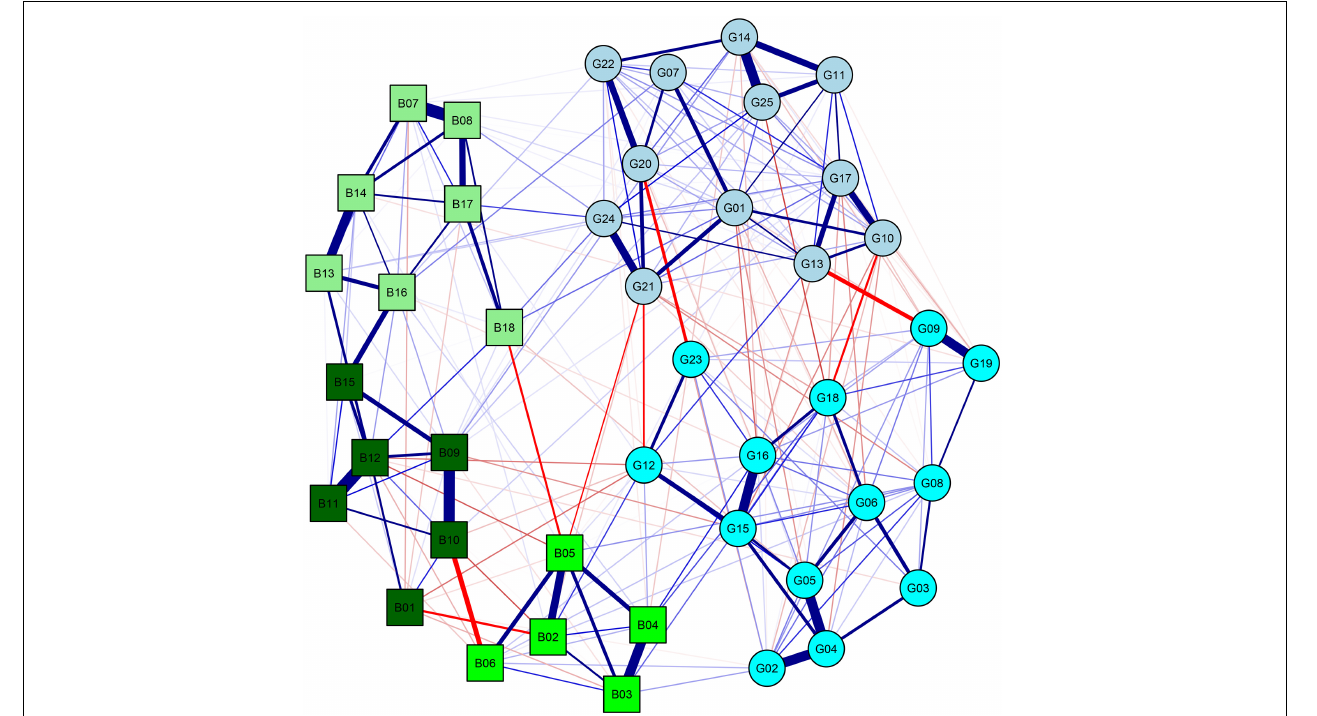
FIGURE 1 | Network of goals and behaviors. Blue and red lines correspond to positive and negative relationships, respectively. Circles correspond to goals, and squared correspond to behaviors. A color was assigned to each behavior and goal according to its highest loadings in the PCA. See Tables 3 , 5 for specific goals and behaviors and details about the PCA.